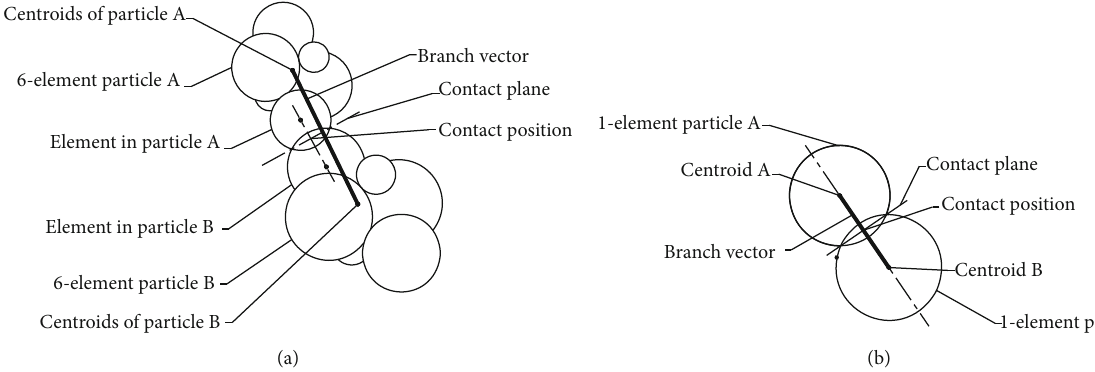
Figure 7: Diagram of contact geometry for nonsphere particle (a) and sphere particle (b) [3].